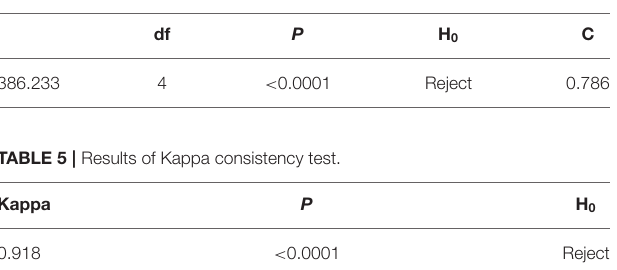
TABLE 4 | Results of chi-square test.